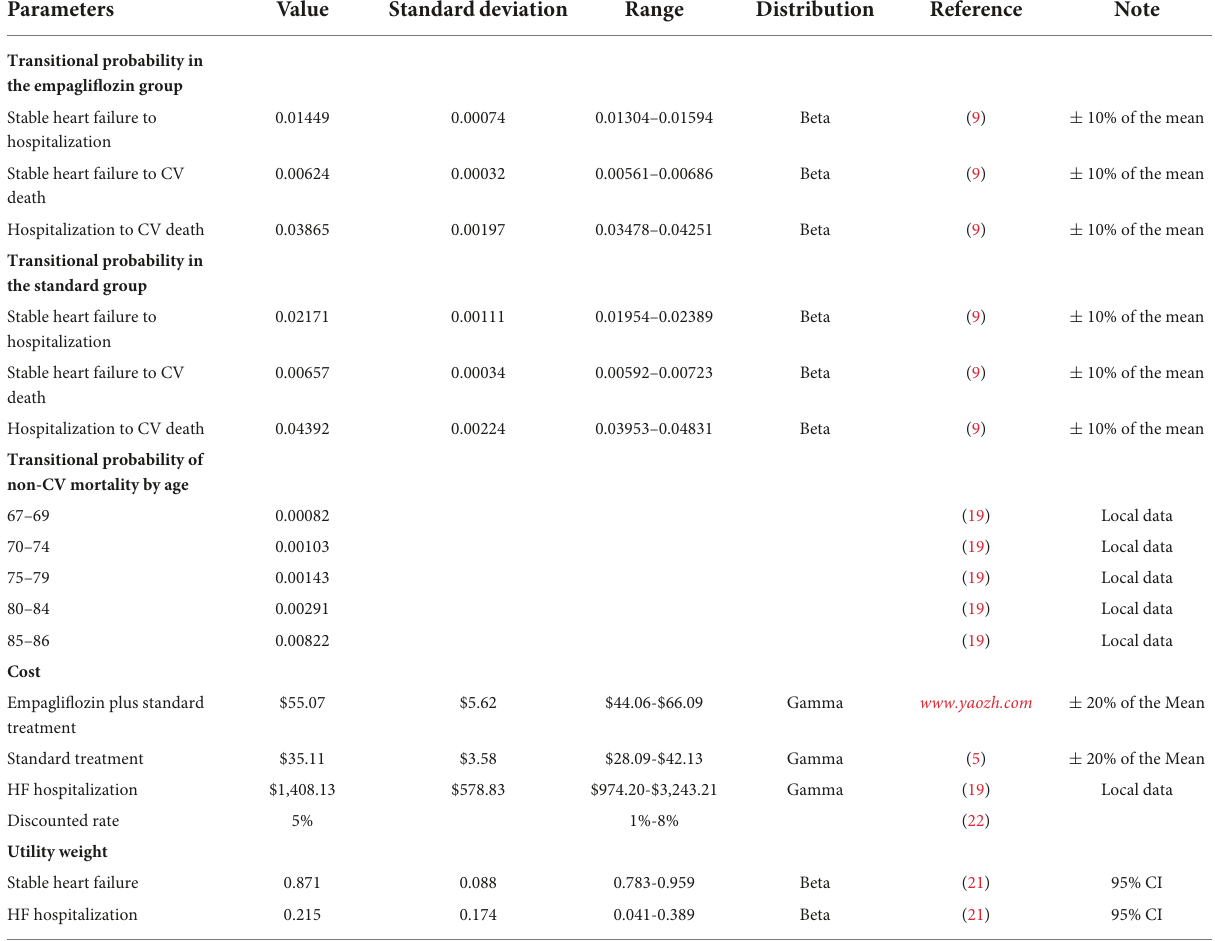
TABLE 1 Input parameters of the Markov